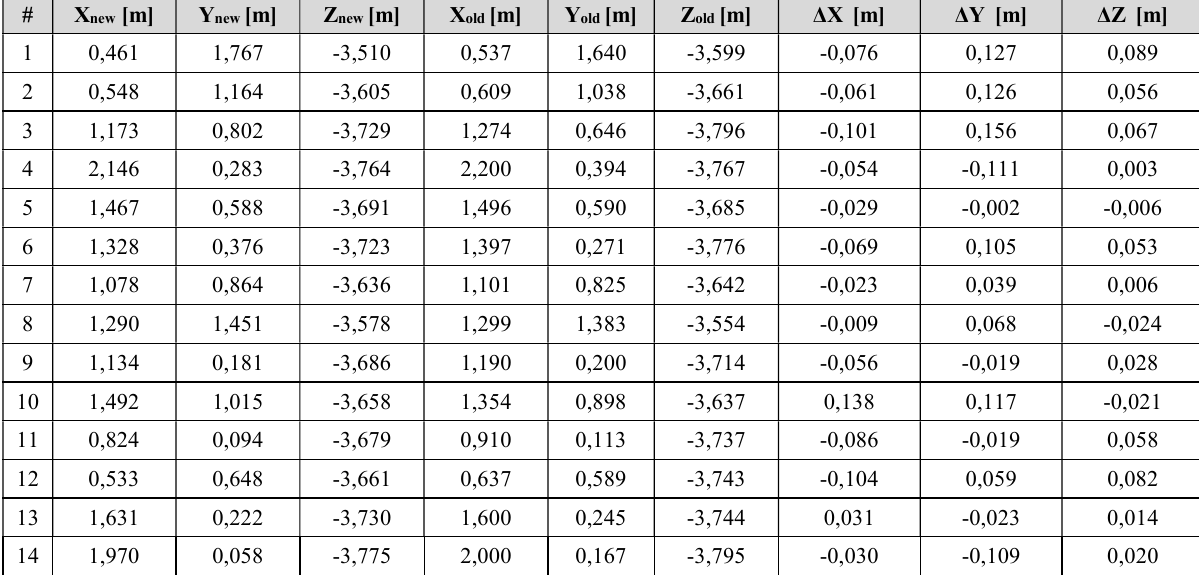
Table 1. Residuals calculation of the feature points for the first case